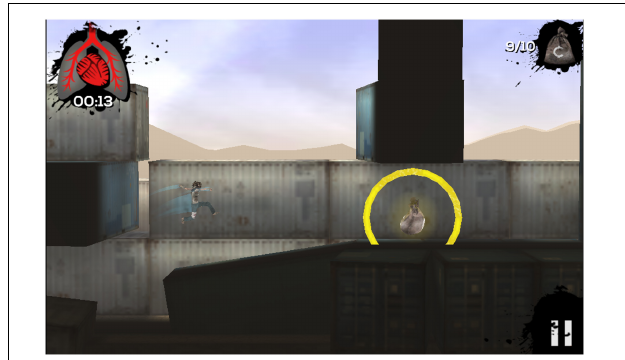
FIGURE 1 | Example screenshot for a mission in Cure Runners (published with permission from Three